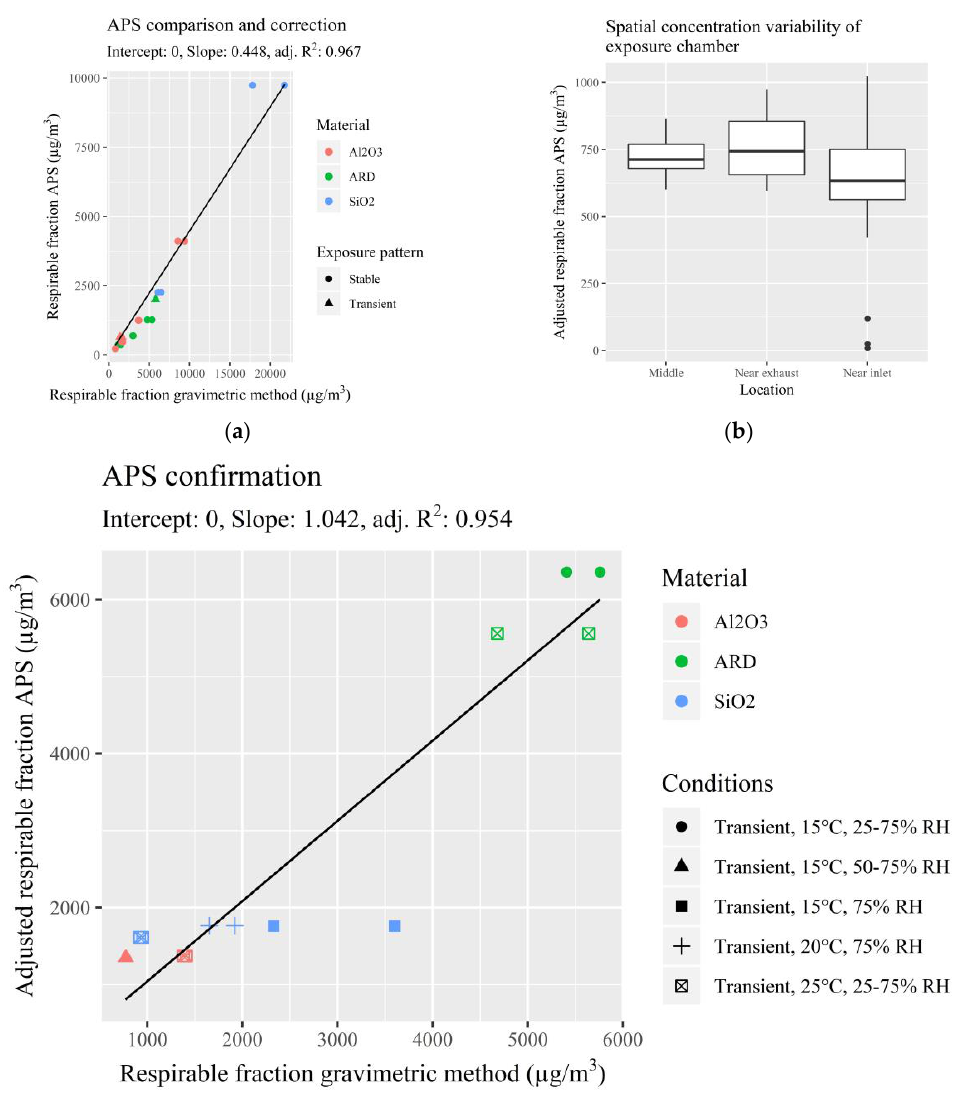
Figure1. Preparativetestingofequipmentandtestchamberenvironmentalconditions.( a )Comparisonand correction of an aerodynamic particle sizer (APS) respirable mass concentrations and respirable gravimetric concentrations; ( b ) testing of spatial variability within the exposure test chamber by comparing sampling locations using an APS; and ( c ) confirmation of adjusted APS respirable mass concentrations under changing evaluation